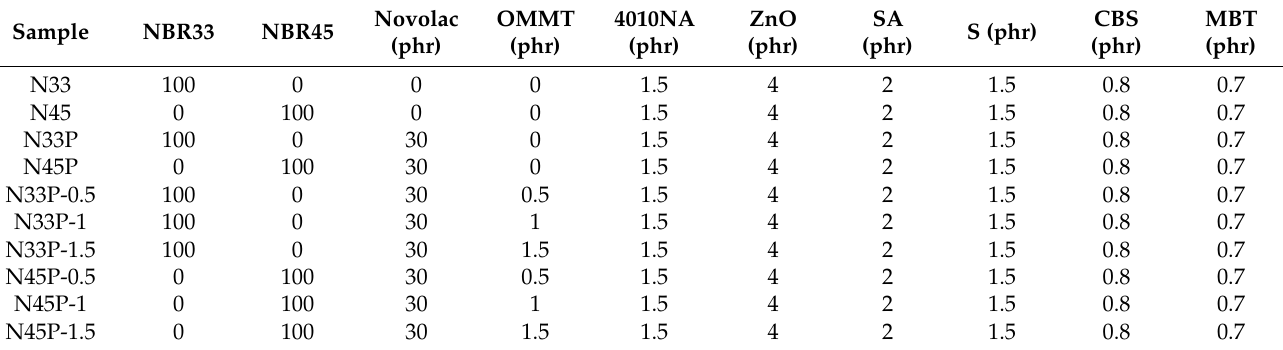
Table 2. Composition and coding of the